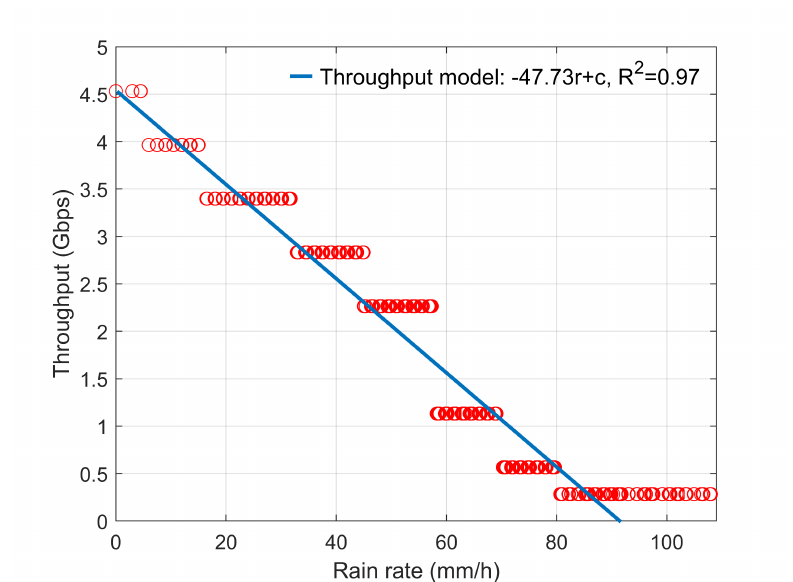
Figure 7. Variation of throughput with rain rate at full-duplex wireless back-haul E-band link along 1.8 km.